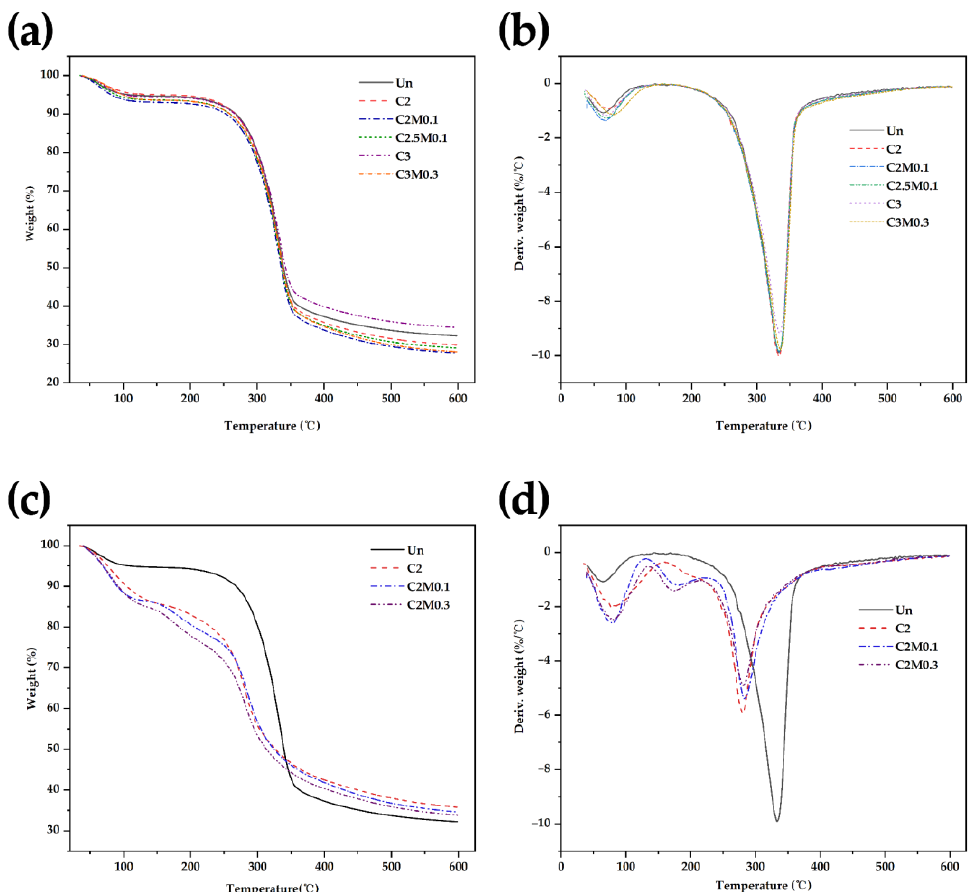
Figure 5. TGA ( a ) and DTG ( b ) plots of the uncoated paper (Un) and coated papers (C2, C2M0.1, C2.5M0.1, C3, C3M0.3). Additionally, TGA ( c ) and DTG ( d ) plots of the uncoated paper (Un), chitosan coating (C2), and mixture coatings (C2M0.1, C2M0.3).